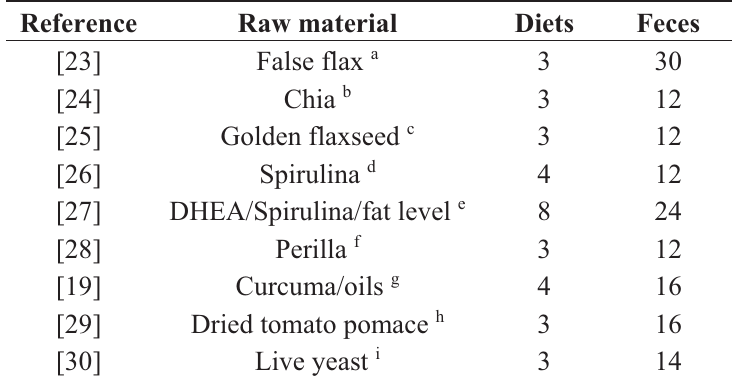
Table 1. Data set characteristics of the 34 experimental iso-energetic and iso-nitrogenous diets involved in nine referenced